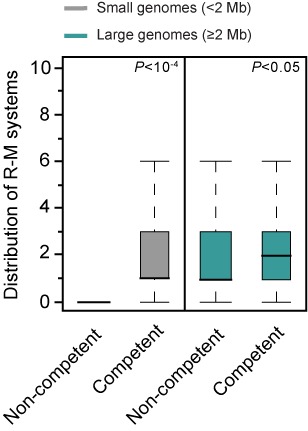
Box plots of the co-occurrence of R-M systems and natural competence machinery in small (<2 Mb) and large (≥2 Mb) genomes. Error bars represent standard deviations. Mann–Whitney–Wilcoxon test P value is indicated next to the box plots.